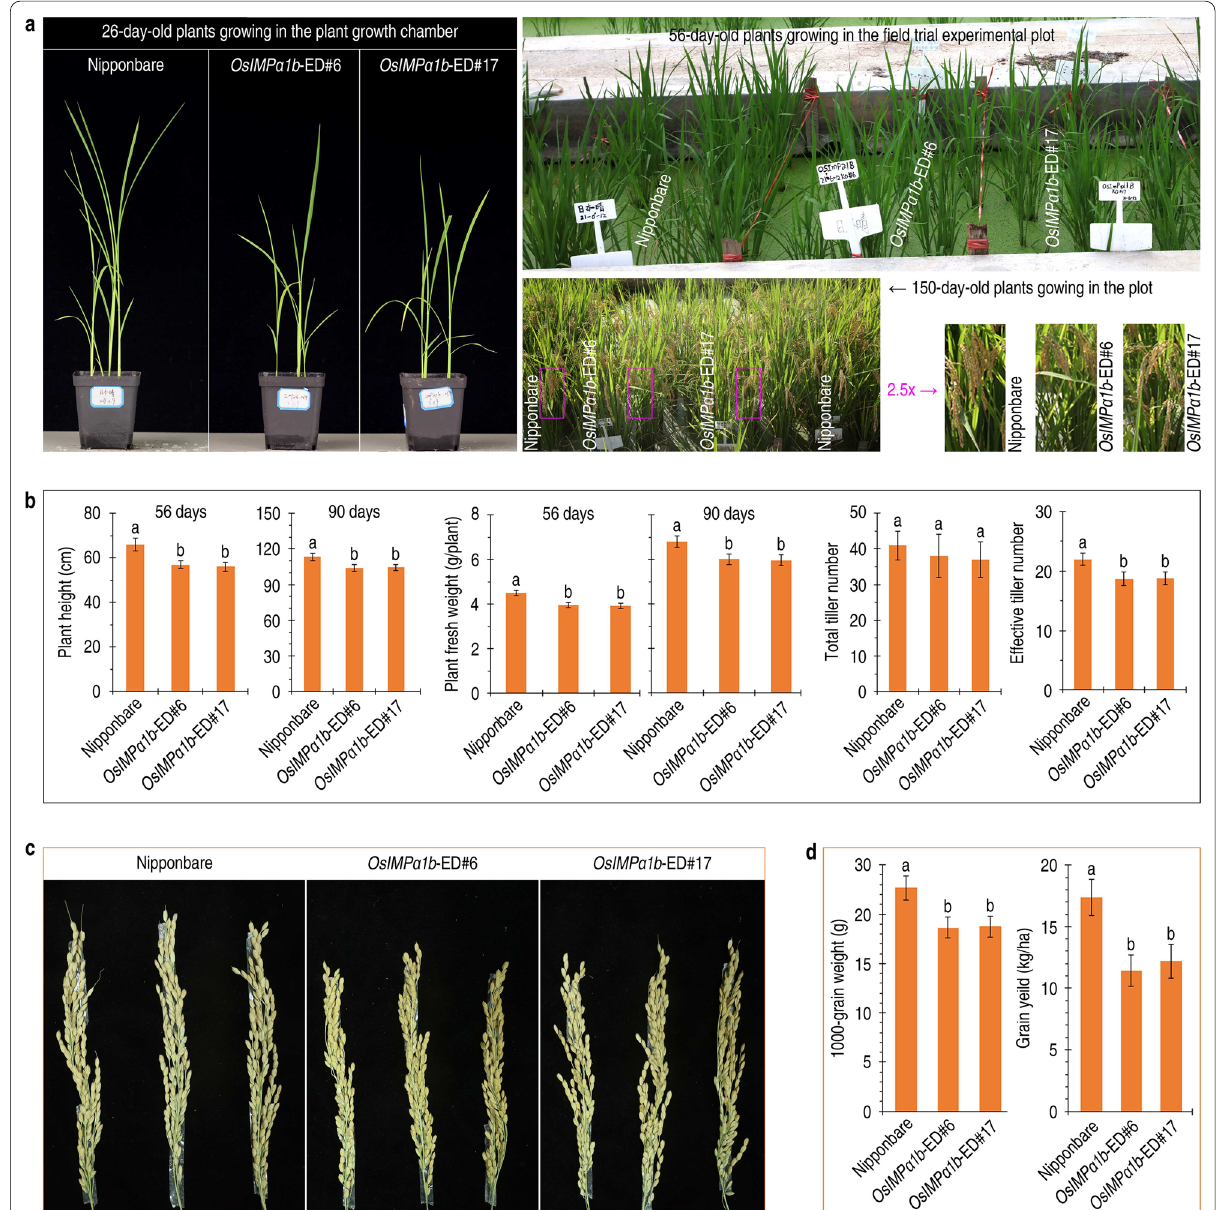
Fig. 3 Imaging and quantitative data showing growth and development differences between the WT plants and OsIMPα1b -edited ( OsIMPα1b -ED) lines. a Plants in a growth chamber and in a specific pond within the experimental field. The image represents plant populations in approximately 1/15 hectare (1 Mu or 667 m 2 ) for each genotype. b Plant height and fresh weight of 56-day-old and 90-day-old plants and tiller number at the heading stage. The data shown are mean values standard deviations (SD) ( n 3). c Three spikelets in a row excised from different rice genotypes ± = and representing grain production in approximately 1/15 hectare (1 Mu or 667 m 2 ) for each genotype. d Grain weight empirically determined in three experimental ponds and grain yield surveyed in 1/15 hectare (1 Mu or 667 m 2 ) divided into the three experimental ponds. The data shown are mean values standard deviations (SD) ( n 3). In b and d , different letters on bar graphs indicate significant differences among different plants ± = based on Duncan’s new multiple range test ( P <